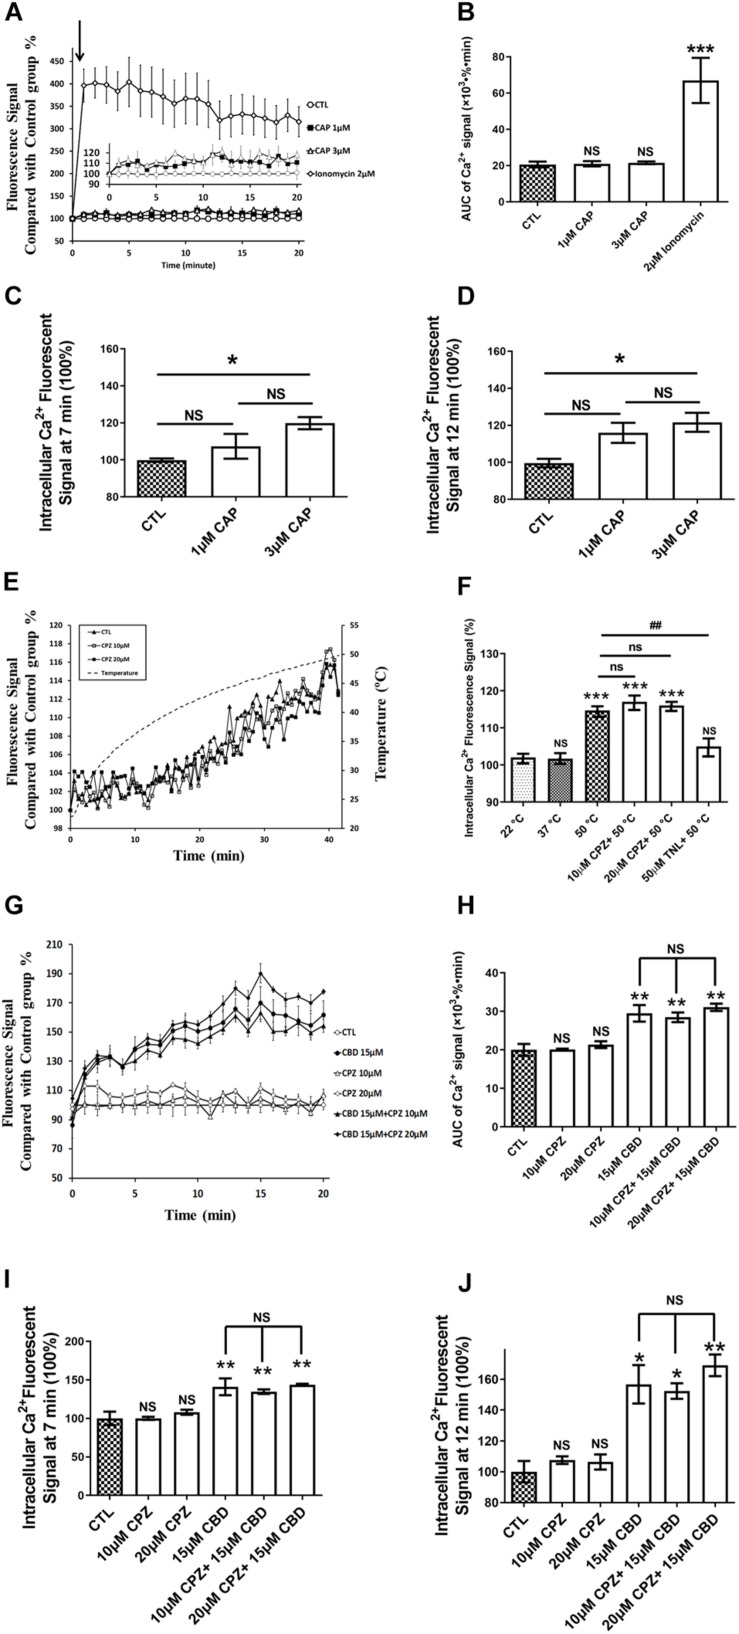
TRPV1 is not functional in hCMEC/D3. (A) Representative time course of [Ca2+]i in hCMEC/D3 under stimulation of TRPV1 by capsaicin (CAP). Cells were plated in 24-wells plate and loaded with Fluo-4-AM as described in section “Materials and Methods.” CAP or ionomycin (as positive control of Ca2+ entry) was added and the fluorescence was recorded. (B) Change of the area under curve (AUC) over the 20 min obtained from the experiment shown in panel (A). (C) Change in [Ca2+]i at T = 7 min obtained from the experiment shown in panel (A). (D) Change in [Ca2+]i at T = 12 min obtained from the experiment shown in panel (A). (E) Change of [Ca2+]i upon heat exposure of hCMEC/D3 for 40 min from room temperature to 50°C. Cells were plated in 24-wells plate and loaded with Fluo-4-AM. The fluorescence was recorded in the presence or not of the specific TRPV1 antagonist capsazepine (CPZ; 10 or 20 μM). (F) Changes in [Ca2+]i in hCMEC/D3 at 22, 37, or 50°C with or without CPZ or Tranilast (TNL, 50 μM) derived from panel (E). (G) Representative time course of [Ca2+]i in hCMEC/D3 stimulated by the TRPV1-2 agonist cannabidiol (CBD, 15 μM) and pre-treated or not with the TRPV1 specific antagonist CPZ. Cells were loaded with Fluo-4-AM. CBD was added and the fluorescence was recorded. When applying CPZ, cells were pre-treated with 10 or 20 μM CPZ for 5 min before incubation with 15 μM CBD and the fluorescence was recorded in the persistent presence of 10 or 20 μM CPZ. (H) Change of the area under curve (AUC) over the 20 min obtained from the experiment shown in panel (G). (I) Change in [Ca2+]i at T = 7 min obtained from the experiment shown in panel (G). (J) Change in [Ca2+]i at T = 12 min obtained from the experiment shown in panel (G). Data are expressed as mean ± SEM and inter-group comparisons were performed by ANOVA with Dunnett a posteriori test. *p < 0.05, **p < 0.01, ***p < 0.001 compared with CTL or 22°C groups or among indicated group.